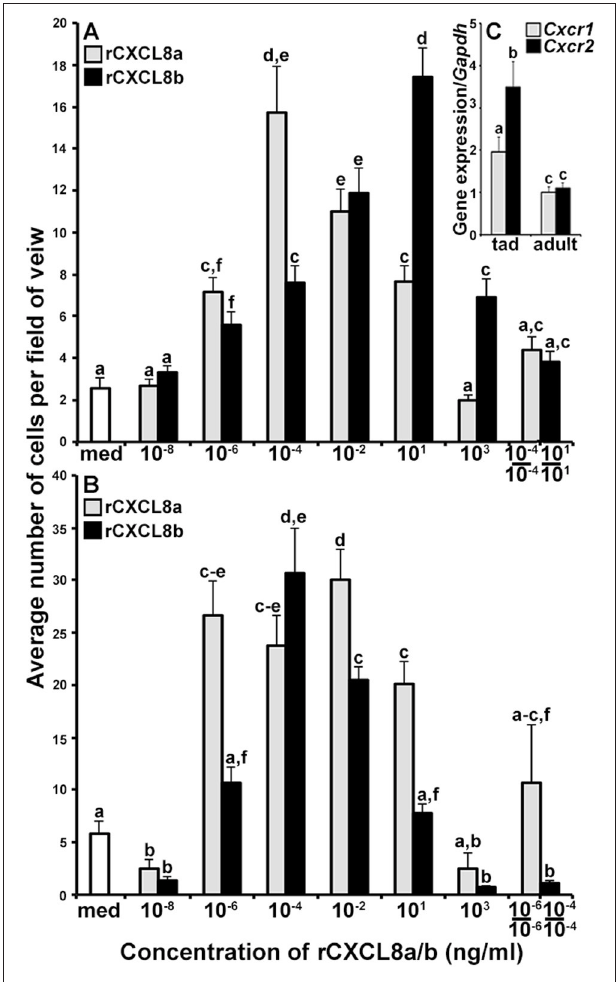
FIGURE 4 | The rCXCL8a and rCXCL8b elicit distinct chemotaxis responses in tadpole and adult granulocytes. (A,B) Medium or increasing concentrations of rCXCL8a or rCXCL8b were loaded into bottom chemotaxis chamber wells and (A) tadpole or (B) adult frog granulocytes (10 5 cells/well) were loaded into top wells, separated by 5 µ m pore filters. After 3h of incubation, the filters were stained with Giemsa, mounted bottom side up and the numbers of migrating cells per field of view enumerated. Cells from three individual animals were used for each chemokine concentration ( N = 3) and the highest tadpole (10 − 4 ng/ml of rCXCL8a; 10 1 ng/ml of rCXCL8b) and adult frog (10 − 6 ng/ml of rCXCL8a; 10 − 4 ng/ml of rCXCL8b) granulocyte chemotactic activities were confirmed in two additional, independent experiments and the results combined and presented here ( N = 9). Chemokinesis was measured by adding respective concentrations of rCXCL8 or rCXCL8b that elicited maximal cell migration, to both lower and upper chambers. (C) Tadpole and adult frog gene expression of Cxcr1 and Cxcr2 relative to Gapdh . All results are presented as means + SEM. Above-head letters denote statistical designations: experimental groups described by distinct letters are statistically different ( P < 0.05) while those marked by the same letters are